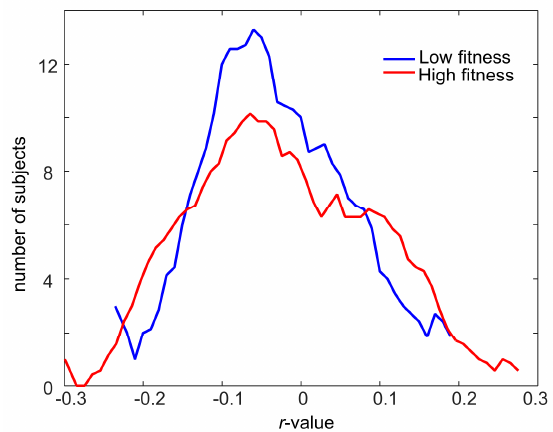
Figure 4. Distribution of Pearson’s correlation coefficients ( r -values) calculated between 36 fecal metabolites including valeric acid, isovaleric acid, leucine, isoleucine, valine, propionic acid, ethanol, lactic acid, alanine, butyric acid, acetic acid, methionine, acetone, glutamic acid, pyruvic acid, aspartic acid, sarcosine, trimethylamine, lysine, malonic acid, methanol, carnitine, glycine, glycerol, guanidinoacetic acid, betaine, threonine, malic acid, glucose, galactose, uracil, fumaric acid, tyrosine, phenylalanine, xanthine, and formic acid and eight lipoproteins including total chol , HDL chol , LDL chol , VLDL chol , total chol /HDL chol , total chol /HDL-Apo A, LDL chol /HDL chol and VLDL chol /HDL chol . The correlation analysis was performed separately for low fitness (blue) and high fitness subjects (red).